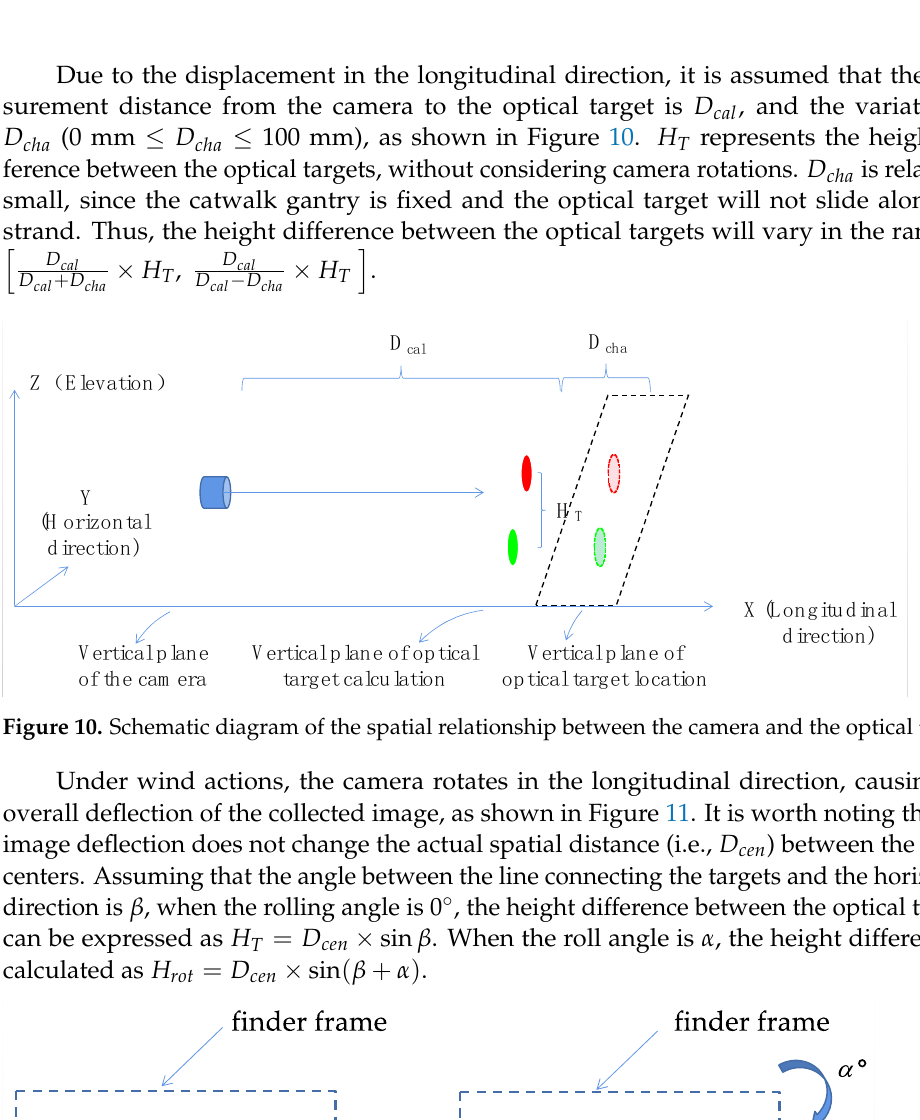
Figure 12. Optical targets appearing at different positions in the monitoring range due to camera shakings. Collectively, the maximum measurement errors caused by the wind-induced camera shaking are summarized in Table 3, according to the empirical values of key parameters. It can be concluded that the image deflection caused by the camera’s roll angle is the major contributor to the measurement error.